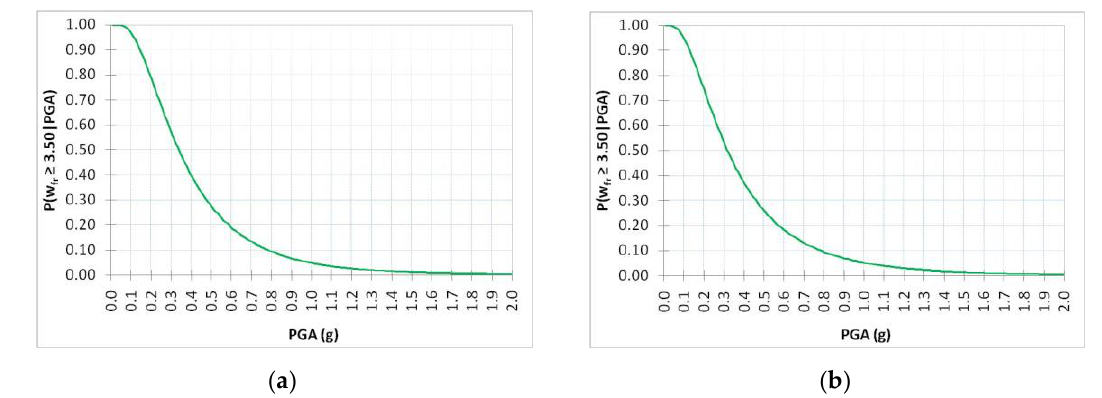
Figure 10. Fragility curve in terms of probability of opening for ( a ) AC1 and ( b ) AC2.